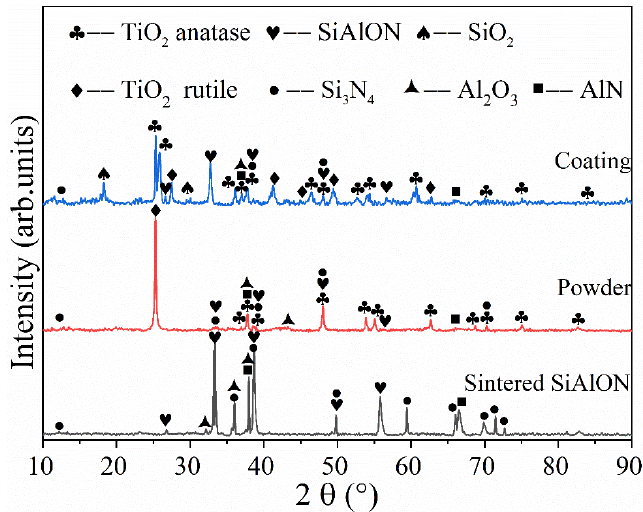
Figure 4. XRD patterns of sintered SiAlON, feed powder and coating.